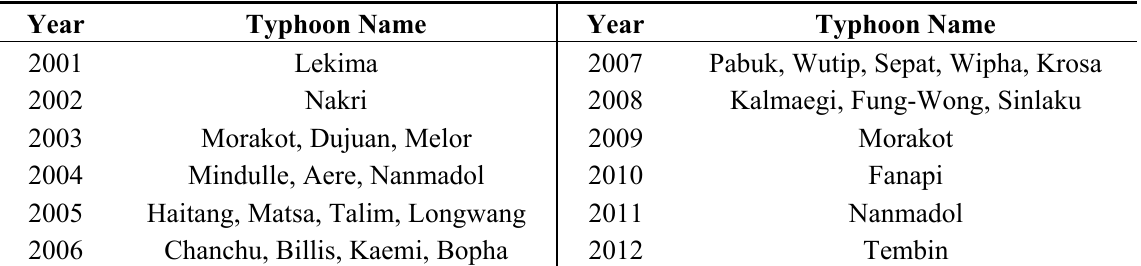
Figure 3. Dawu gauge station and the track of Typhoon Morakot (2009). Table 1. The 28 typhoon events considered in this